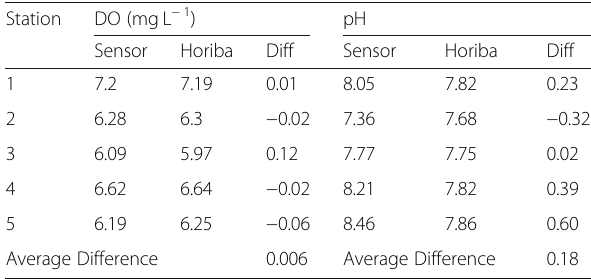
Table 1 Sensor range and response time Sensor